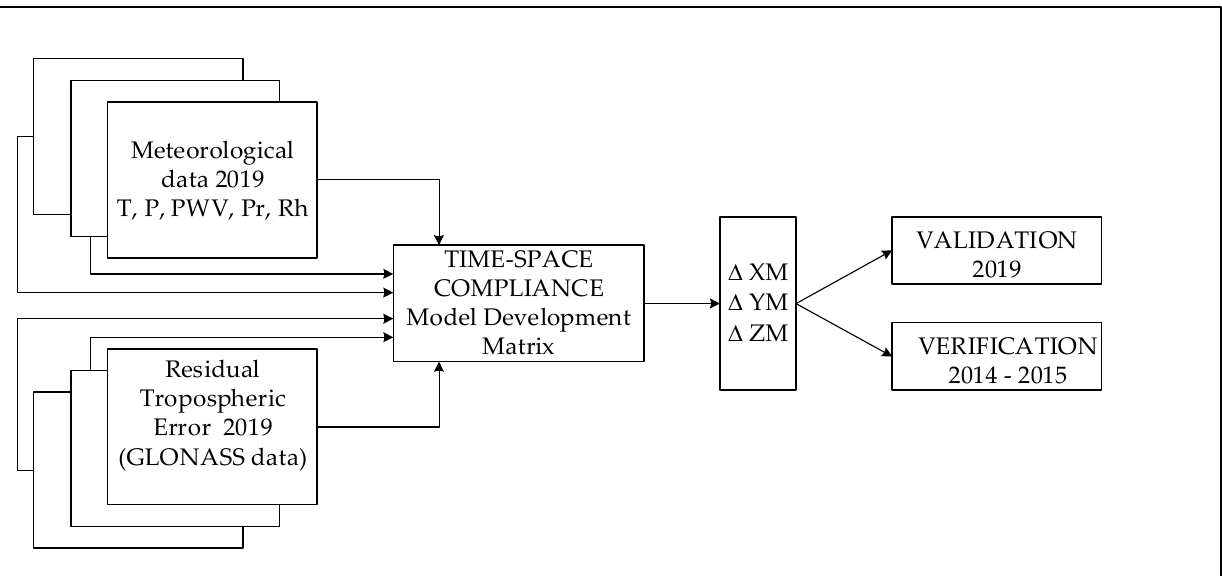
Figure 2. The proposed model development.